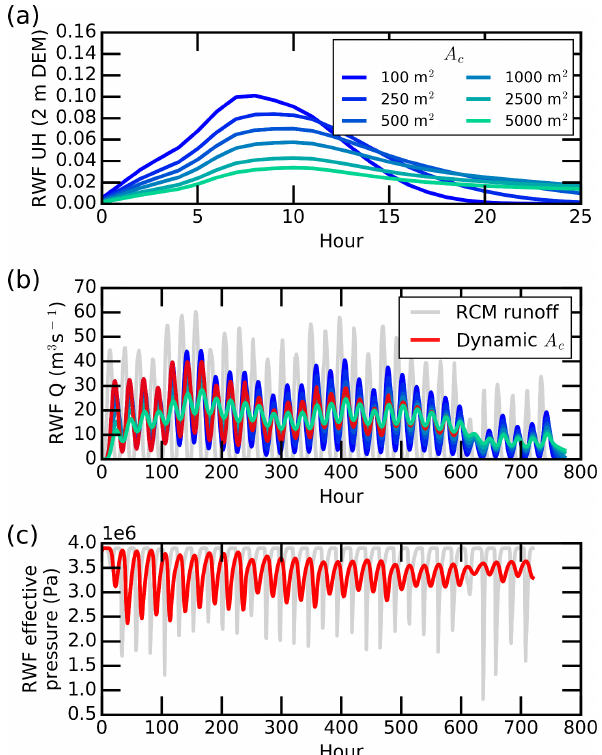
Figure 7. Presentation of (a) unit hydrographs (UHs), (b) moulin discharges, and (c) subglacial effective pressure of IDC1 during July 2015, as simulated by dynamic A c values. A c is the cumulative contributing area required to initiate a supraglacial meltwater chan- nel, and dynamic A c values are used as a proxy for time to simulate the temporal evolution of supraglacial stream and river networks. Simultaneous RCM runoff (gray line) is shown to indicate the ef- fect of surface meltwater routing processes on moulin